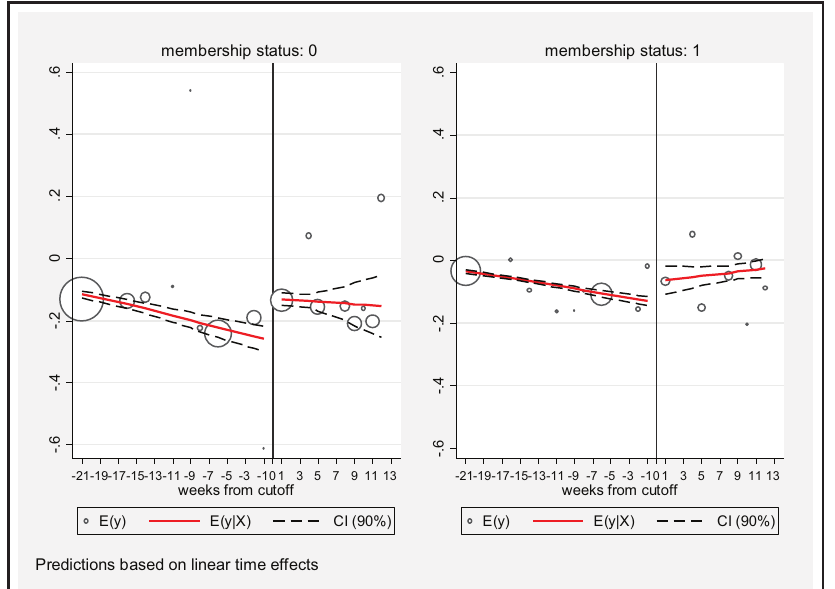
Figure 7 The effects of extensions by affiliation